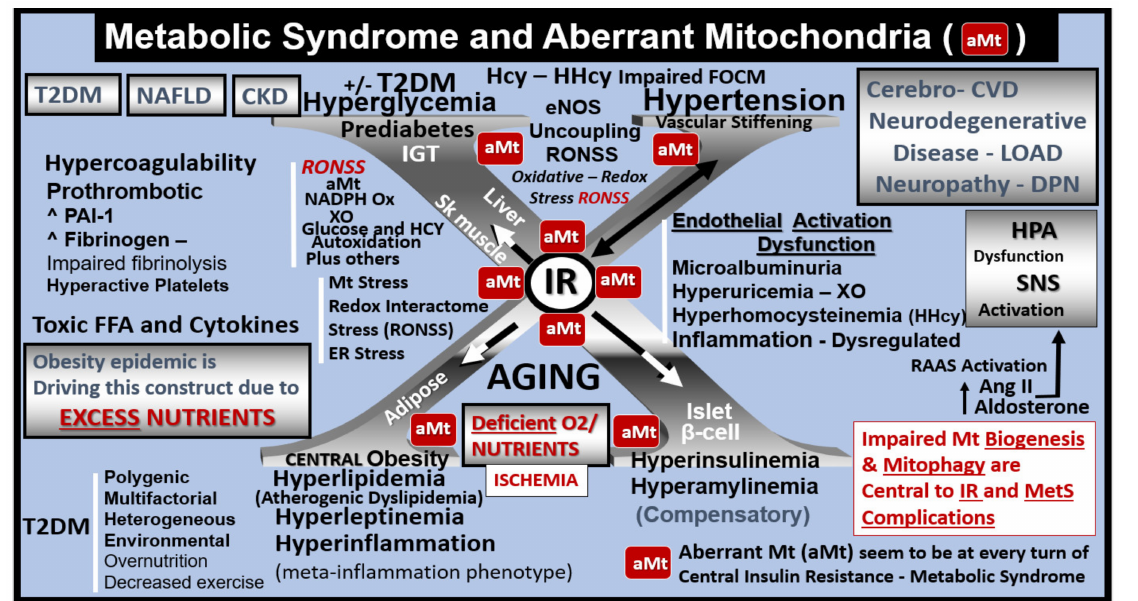
Figure 4. The metabolic syndrome (MetS) and aberrant mitochondria (aMt). This image illustrates how the complex MetS and aMt can have a tremendous interaction and impact with multiple crosstalk as they intersect. In its simplest form, the MetS may be characterized by the clustering of multiple metabolic abnormalities and clinical disease states associated with multiple vulnerabilities. The central “X” in this figure honors Jerry Reaven [18] who initially coined the term Syndrome X and championed the concept that the resistance to insulin-mediated glucose disposal—insulin resistance (IR) was a characteristic of patients with type 2 diabetes mellitus (T2DM) and cerebrocardiovascular disease (CVD), which was later termed MetS by Scott Grundy [19]. There are four arms to this letter X and each arm has a designated condition to further illustrate the “H” phenomenon, representing a “hy- per” state, e.g., hyperlipidemia, lower left; pancreatic islet β -cell hyperinsulinemia/hyperamylinemia, lower right; hypertension and vascular stiffening, upper right; hyperglycemia, upper left. Note how IR is placed central to each of the four arms and how it is surrounded by aMt, which represents Mt dysfunction and damage [17]. Each of the four arms is important and note the arrows depicting that IR can impact each of the tissues and the clinical disease states. Further, note that the central IR is surrounded by the red coloring of the aMt that are so important to this review. Additionally, the MetS constitutes a milieu conducive to tissue oxidative-redox stress. Oxidative-redox stress incorporates the sum of reactive oxygen, nitrogen, and sulfur species stress (RONSS) and its cellular RONSS interactome and inflammation that create a vicious cycle. The multiple metabolic toxicities associated with the MetS including the RONSS interactome and endothelial dysfunction combine to weave a complicated mosaic fabric, which is also known to be associated with the activation of the renin-angiotensin-aldosterone-system (RAAS). Additionally, cerebrocardiovascular disease (CVD), which includes neurodegenerative disease such as late-onset Alzheimer’s disease (LOAD) and/or a diabetic encephalopathy and chronic kidney disease (CKD) together comprising the heart–brain- kidney axis that is involved when there is aortic vascular stiffening associated with MetS and